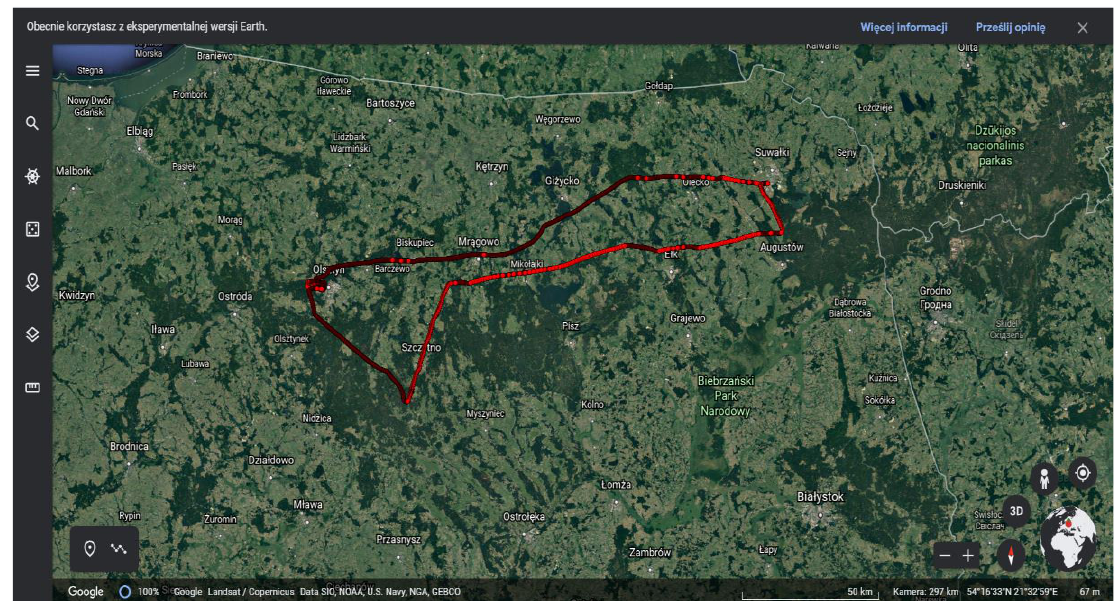
Figure 4. The horizontal trajectory of Diamond DA 20-C1 aircraft in the Google Earth platform [46].